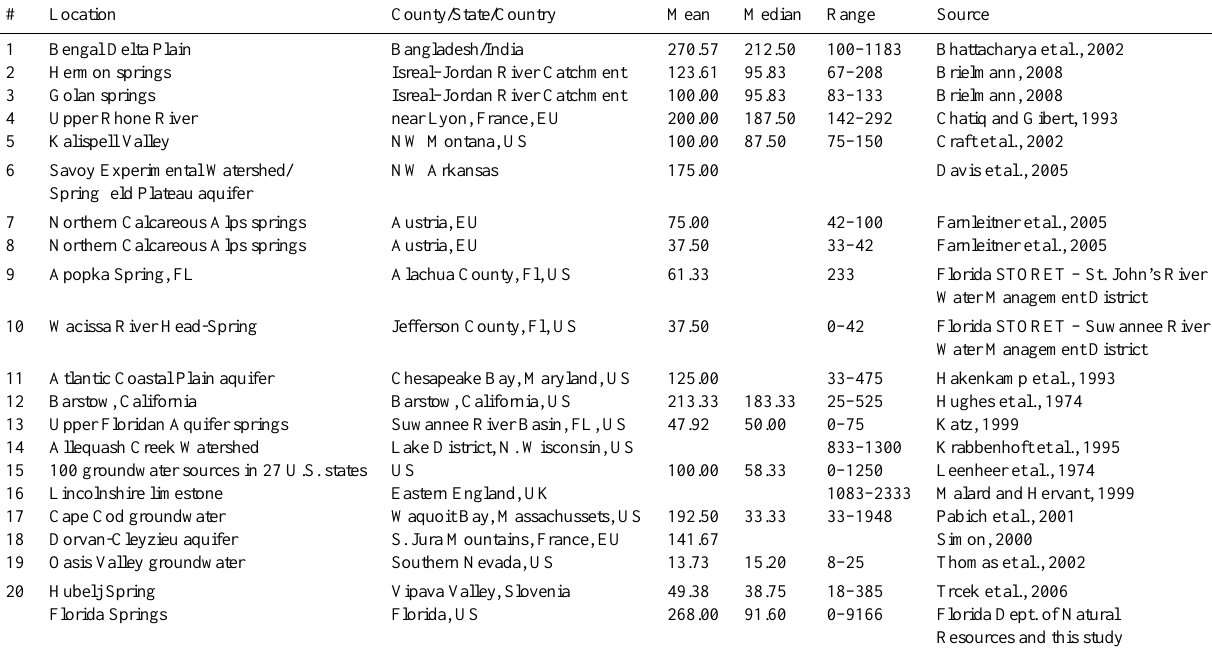
Table 3. Reported DOC concentrations (µmolCL − 1 , mean, media and range) for groundwater and springs